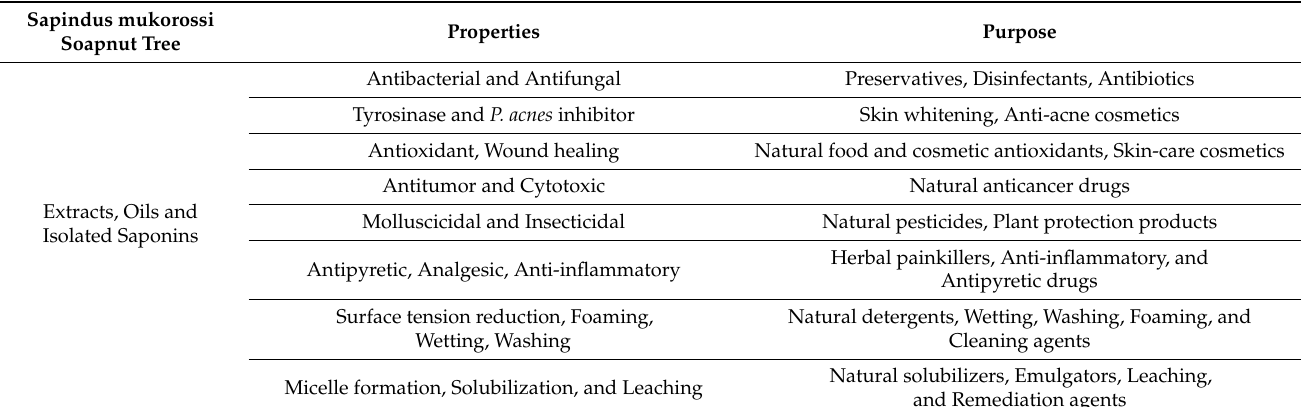
Table 2. Preliminary assessment of the purpose of Sapindus mukorossi as an industrial raw